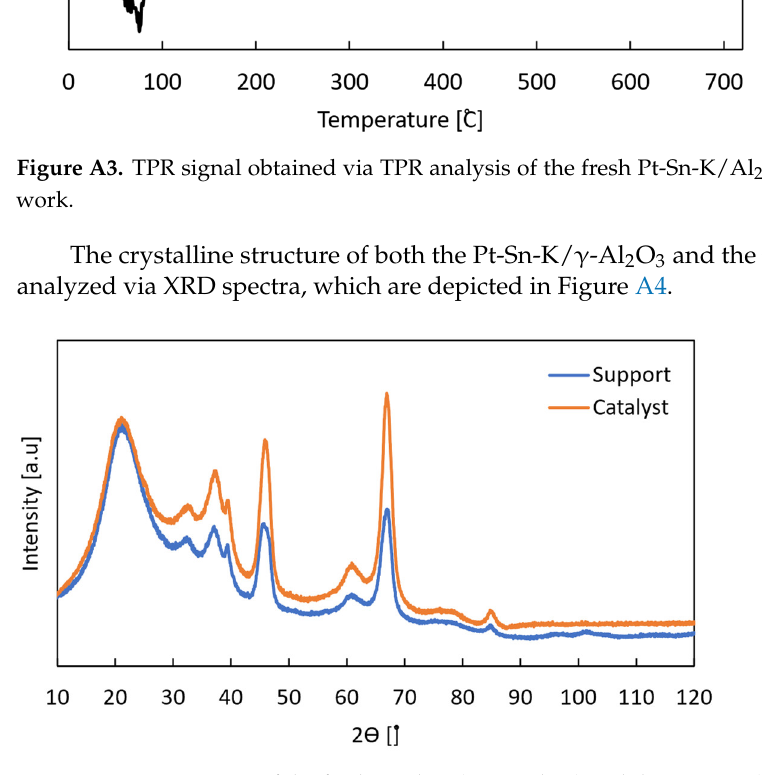
Figure A4. XRD spectra of the fresh catalyst (orange line) and the support (blue line) samples.